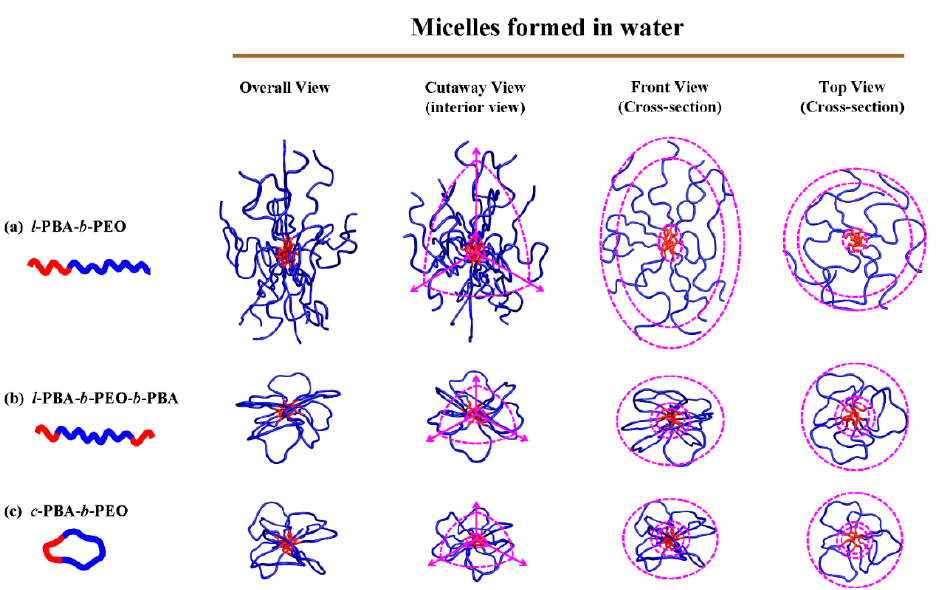
Figure 7. Schematic representations of the micelle structures of amphiphilic topological block copolymers based on the structural parameters obtained from the quantitative X-ray scattering data analyses using a three-phase ellipsoid scheme.